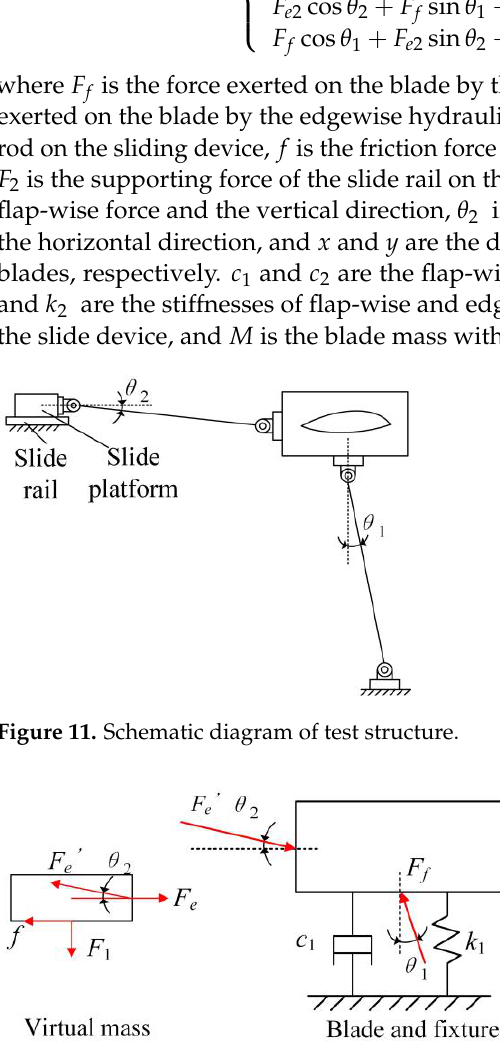
Figure 12. Force diagram of Figure 12 Force diagram of structure. Figure 12 Force diagram of structure.